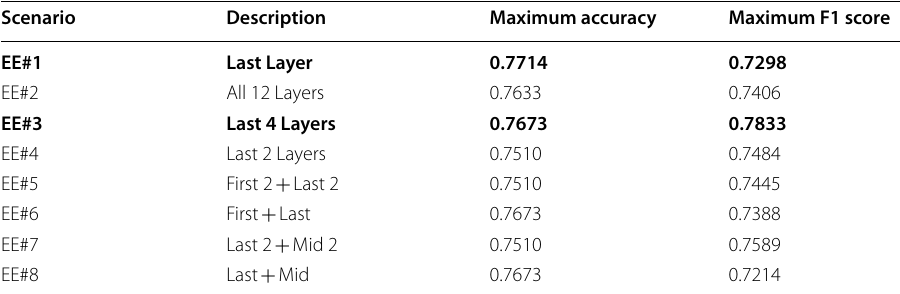
1e-4 and eps 1e-4 = =